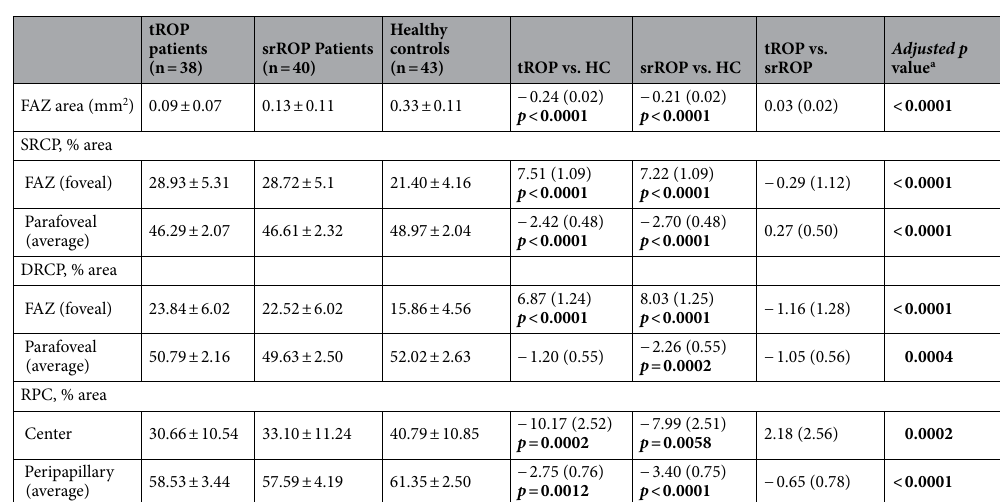
Table 3. Comparison of foveal avascular zone area and vessel densities of the superficial, deep retinal capillary plexus and radial peripapillary capillary segment between preterm patients with a history of retinopathy of prematurity with treatment, spontaneously regressed, and full-term healthy controls. tROP, retinopathy of prematurity with laser treatment; srROP, spontaneously regressed retinopathy of prematurity; HC, healthy controls; FAZ, foveal avascular zone; SRCP, superficial retinal capillary plexus; DRCP, deep retinal capillary plexus; RPC, radial peripapillary capillary; SE, standard error; CI, confidence interval. Values are shown as mean ± standard deviation. a p value was calculated by multivariate linear regression with adjustment for age and Bonferroni correction multiplied by 3. Boldface indicates statistical